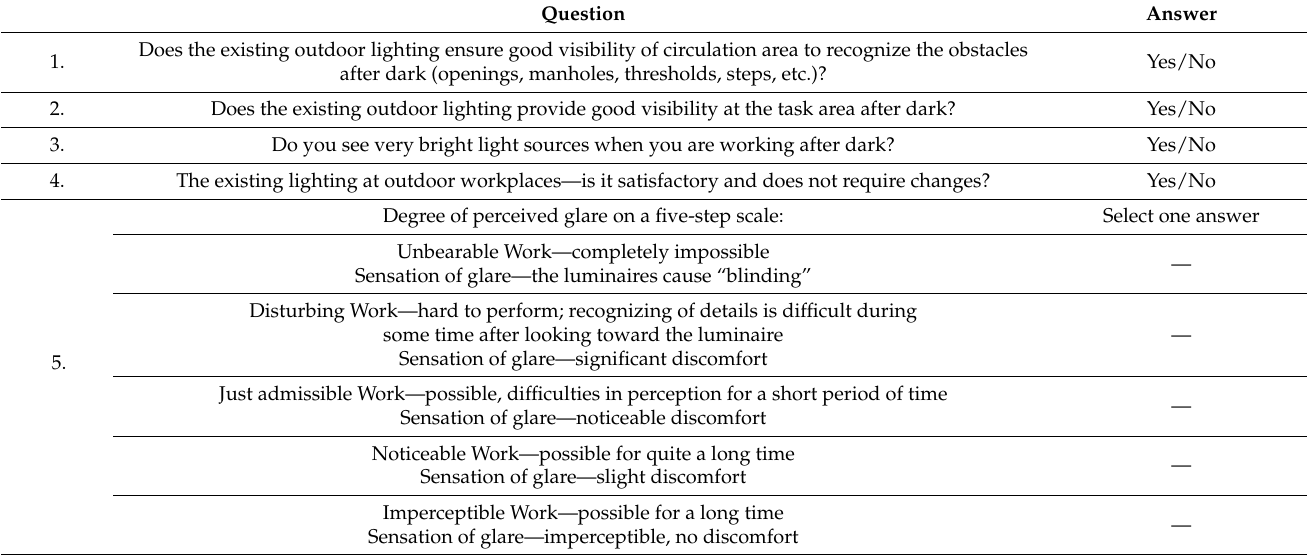
Table 2. Questionnaire for interview for subjective assessment of